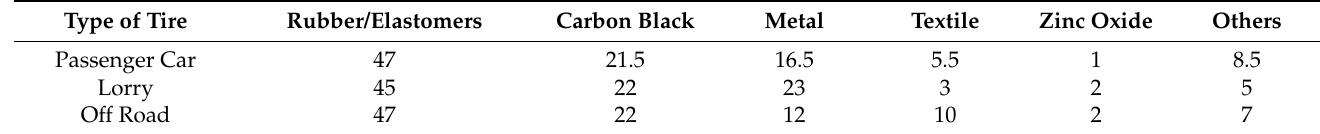
Table 1. Typical tire composition (wt.%) [10].